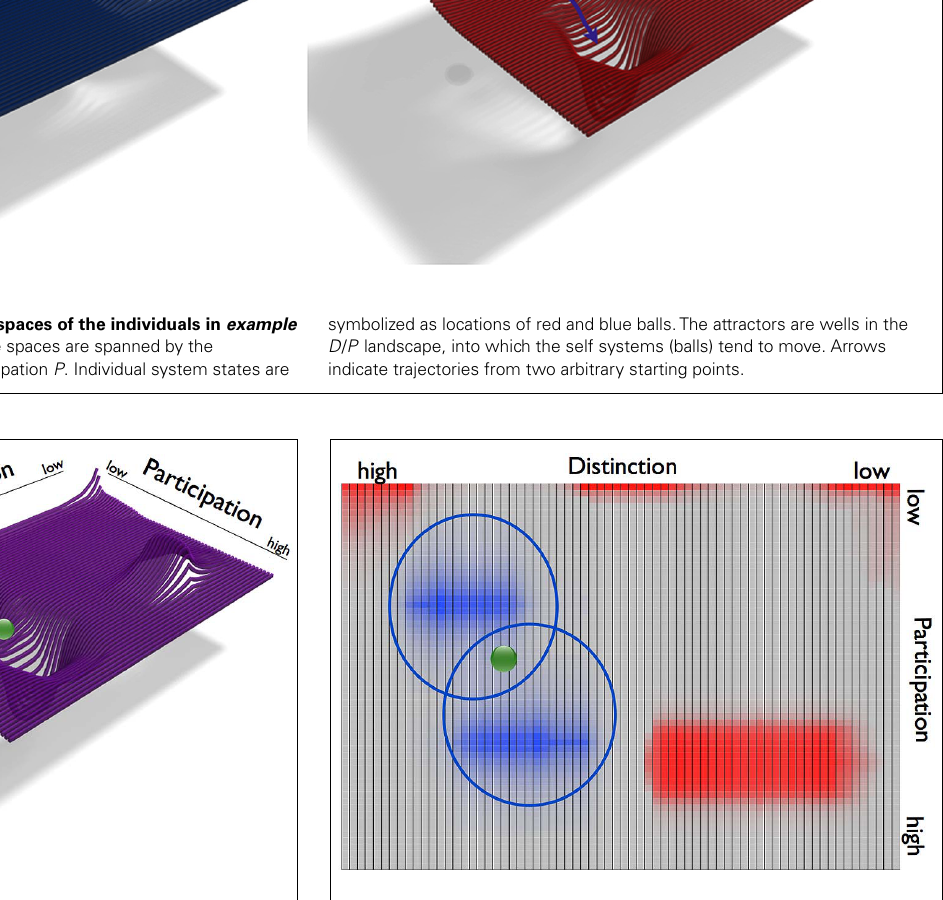
FIGURE 6 | Illustration of the dyadic phase space of example 2 . The dyadic phase space corresponds to the individual phase spaces from Figure 5 .The couple’s state (green ball) is located in the saddle, the region connecting the individual attractor regions.